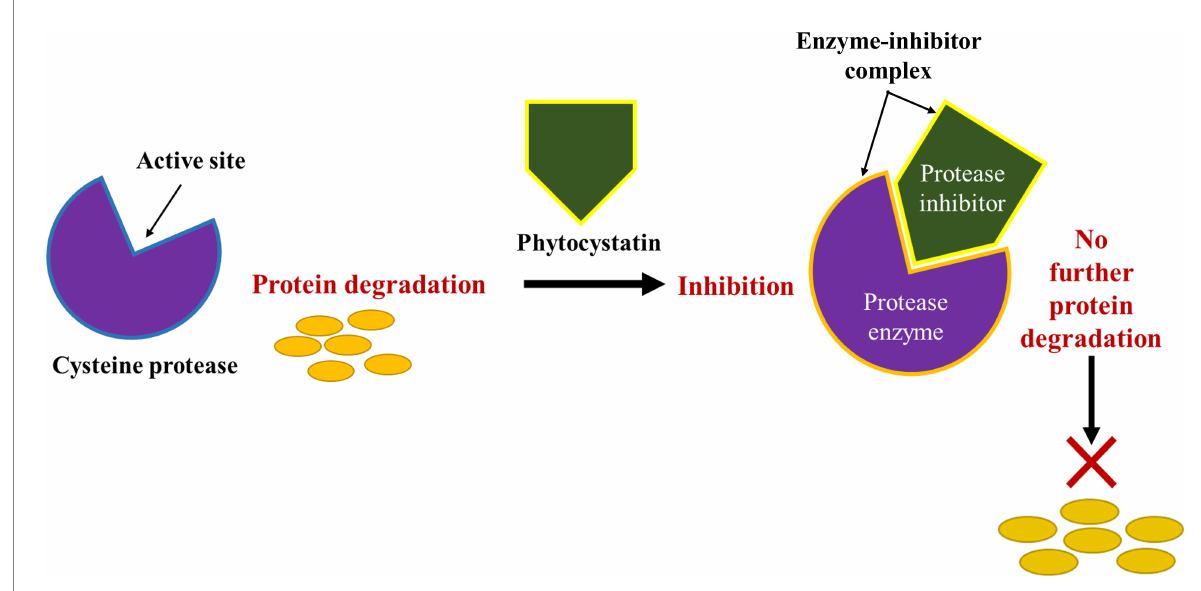
FIGURE 1 A typical inhibitory action of protease inhibitor (cysteine) on protein degradation through the formation of enzyme-inhibitor